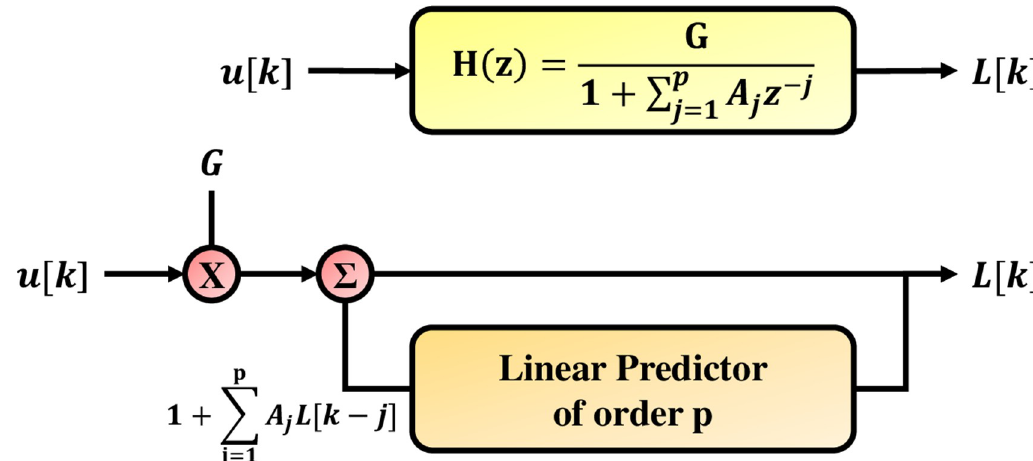
Fig 1. This figure presents the speech production model through LPC